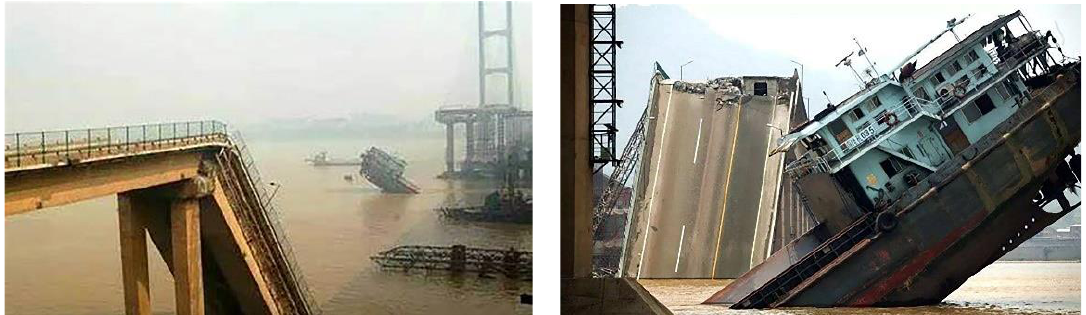
Figure 2. Bridge pier under vessel collision [2].